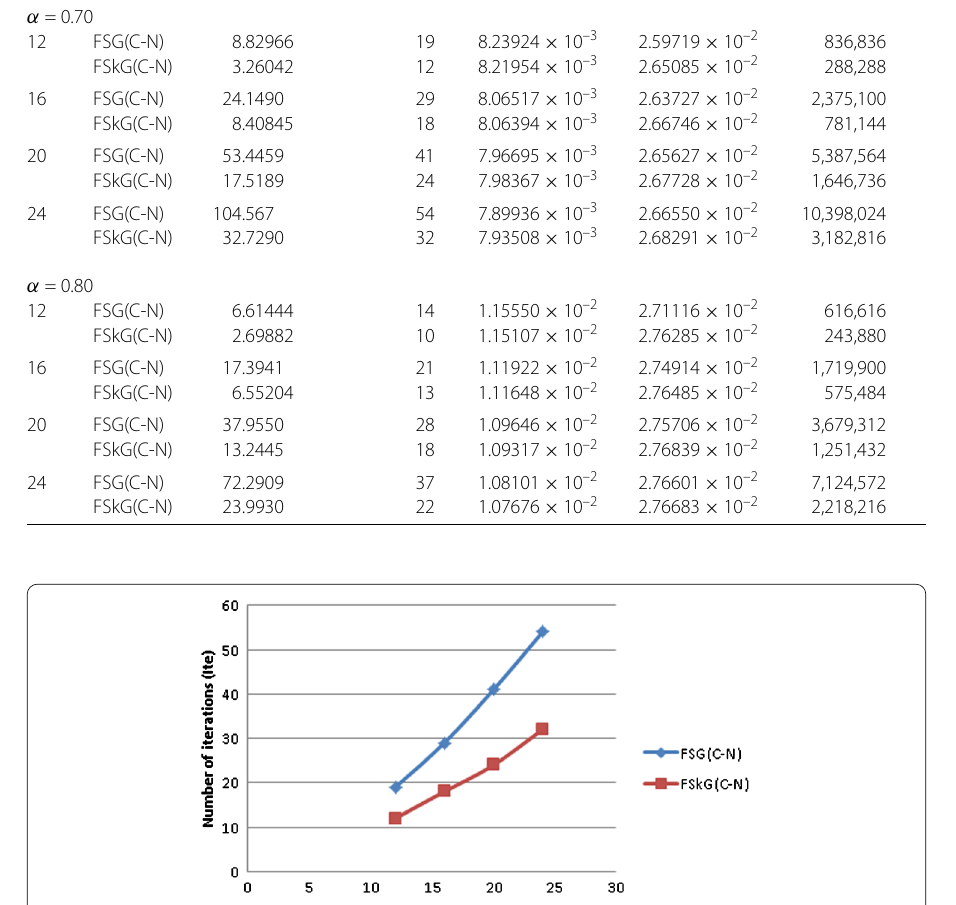
Figure 10 Graph of the number of iterations when α = 0.70 of Example 2